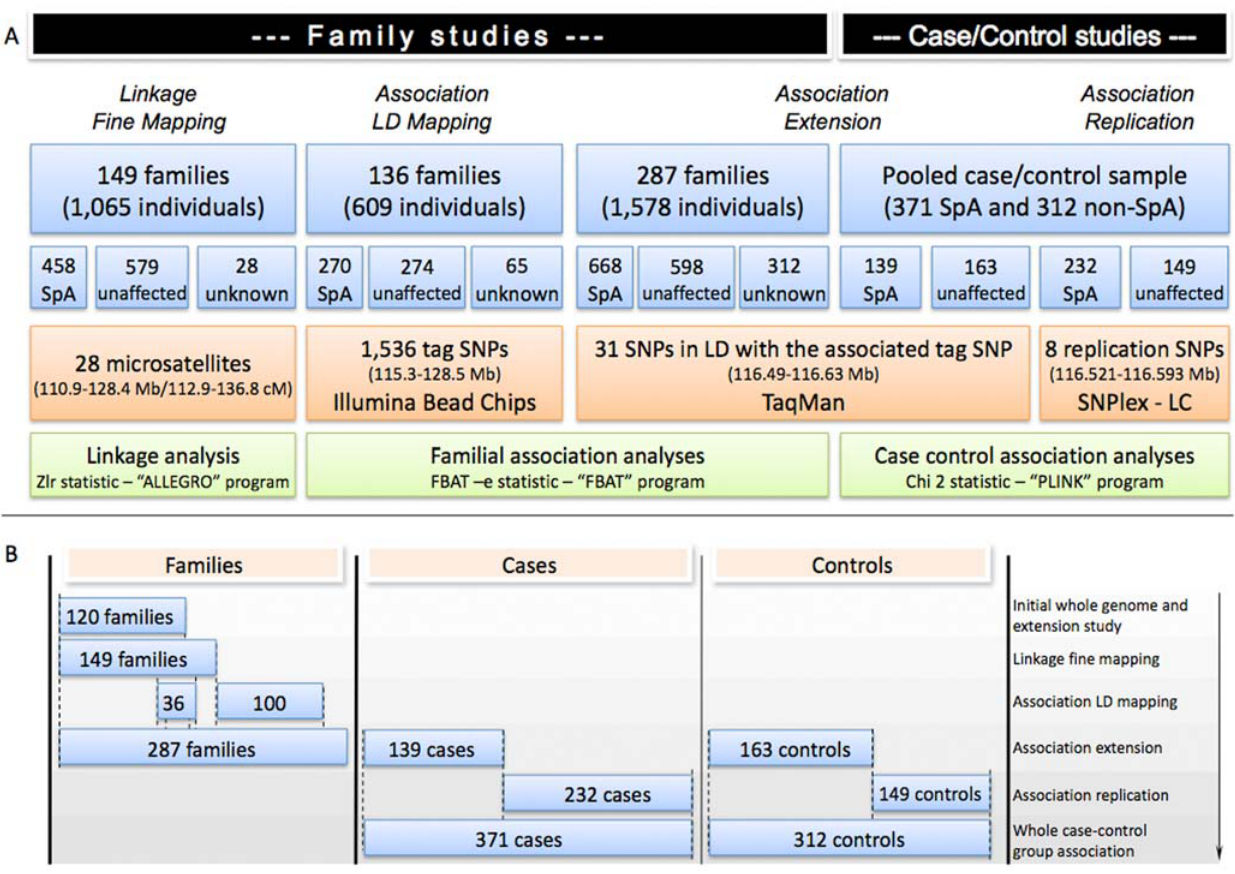
Figure 1. Study design. (A) shows the different stages of the study displayed according to their chronological order from left to right. Frames in blue describe the familial and case/control samples used for each different step. Frames in orange describe the sets of markers, the limits of the intervals covered by these markers on chromosome 9 (in distance from the p-telomere), and the techniques used for single-nucleotide polymorphisms initial genotyping. Frames in green describe the type of genetic analysis performed, the statistic, and the program used in each case. (B) shows compositions of family and case/control samples used in each step of the study. The three first columns show for each step of the study which familial, and case and/or control sample respectively, was used. The far right column displays, for each genotyped sample, the step of the study in which it was involved. The overlay parts of the samples are matched. Ex: Of the 136 families included in the LD mapping association study, 36 were also used in the fine mapping linkage study and in the initial whole genome and extension screen. NB: Both case/control samples were composed of independent individuals not tested elsewhere. Abbreviations: LD: linkage disequilibrium, SpA: spondyloarthritis, SNP: single-nucleotide polymorphism.